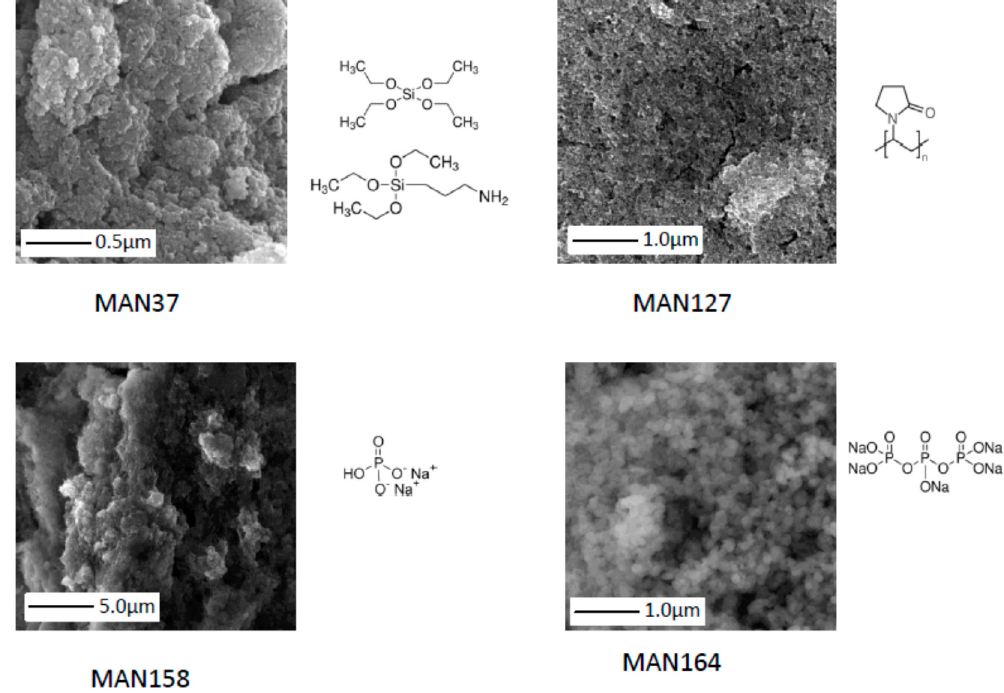
Figure 1. Scanning electron microscopy (SEM) of magnetic particles showing the external structure of the particles caused by chemicals used in modification of maghemite core. MAN37 (silica-coated), MAN127 (polyvinylpyrrolidone-coated), MAN158 (phosphate-coated), and MAN164 (tripolyphosphate-coated). content, acidic pH, and dehydration properties was used to precipitate a total of ~10 11 copies of purified 700 base paired double-stranded DNA on magnetic particles. DNA/binding